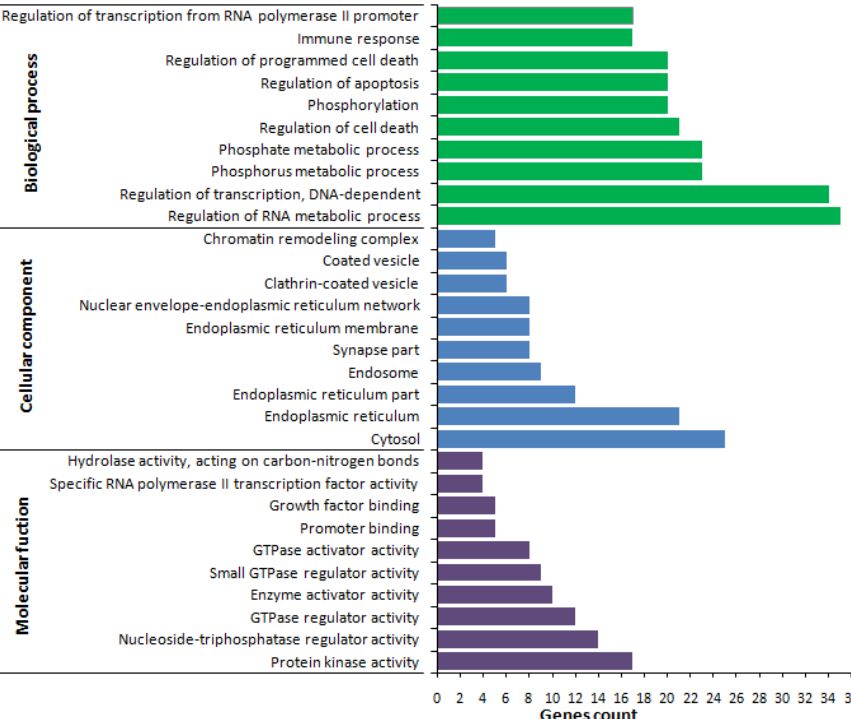
Figure 3. The ten most enriched gene ontology (functional classifications) of differentially expressed genes (DEGs) between resistant and susceptible YWGs.